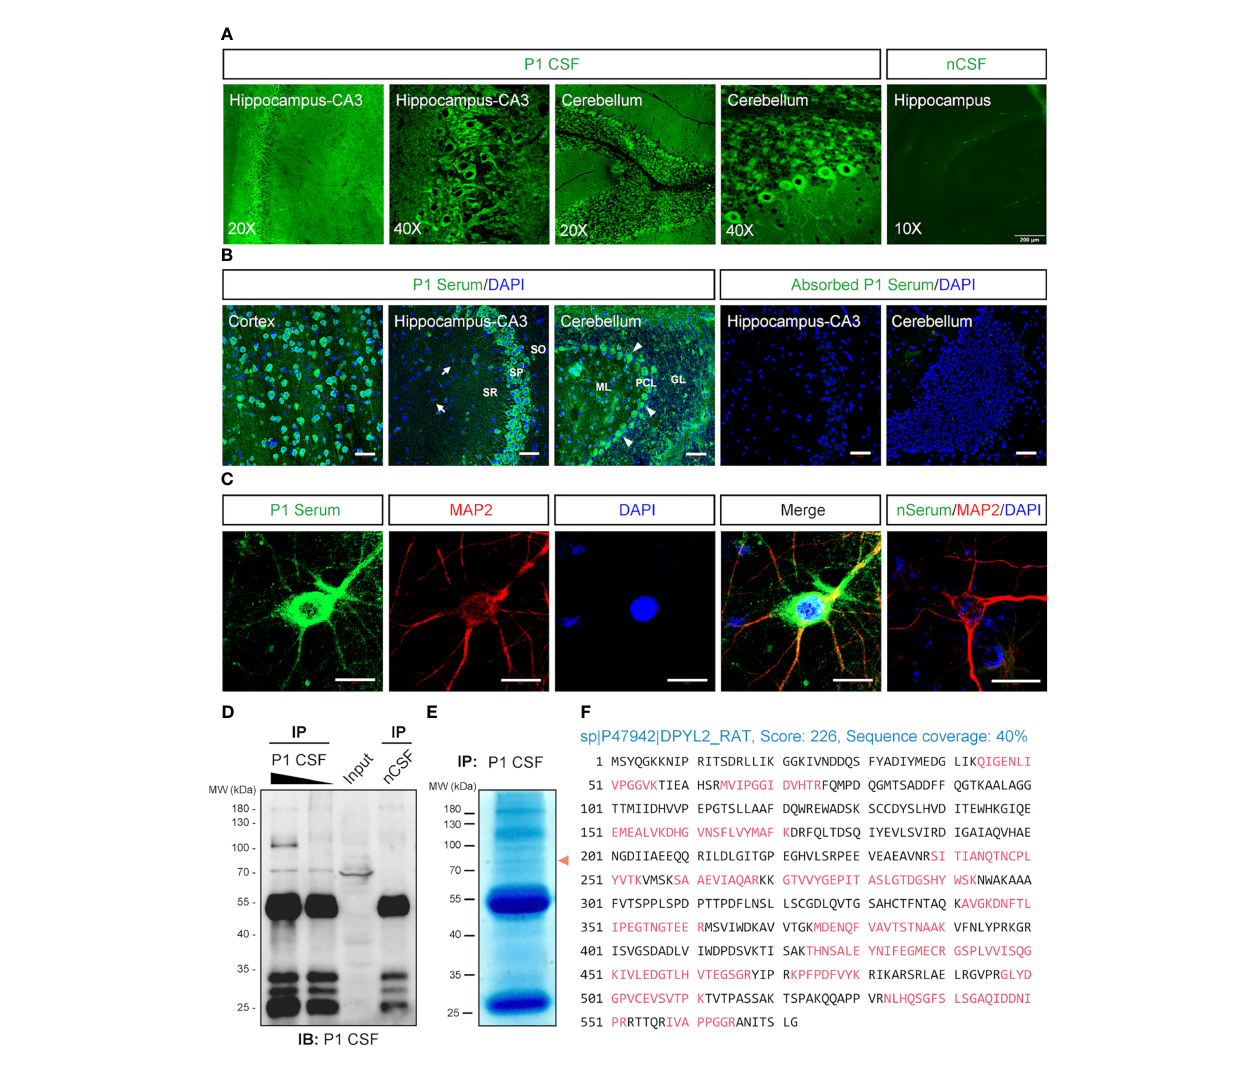
FIGURE 3 | Identi fi cation of the autoantibody in a patient with acute encephalitis. P1 patient was diagnosed with encephalitis. The CSF sample from a control patient with carpal tunnel syndrome (nCSF) and the serum from a healthy person (nSerum) was used as negative controls. (A) Immunostaining on rat brain sections. The CSF from P1 patient had stained on hippocampus and cerebellum. (B) P1 patient ’ s serum stained obviously in the cytosolic compartments of the neurons in the cortex, CA3 area of the hippocampus, and cerebellum on mouse brain sections (green). White arrows, possible oligodendrocytes; arrow heads, Purkinje cells. CRMP2-expressing HEK293T cell absorbed P1 patient ’ s serum had no obvious staining. Cell nuclei were stained blue with DAPI. (C) P1 patient ’ s serum (green) stained positively in the soma and dendrites of cultured mouse cortical neurons which were labeled with anti-MAP2 Ab (red). (D, E) IP of P1 CSF with rat brain protein lysate. In total, 500 m l (lane 1) and 100 m l (lane 2) P1 CSF were applied to IP with 10 mg total protein of fresh rat brain lysate, respectively. Moreover, 500 m l nCSF was used for negative control. A positive band around 70 kDa was pulled down by P1 CSF but not by nCSF. A similar protein size band (red arrowhead) was observed on a parallel gel with Coomassie brilliant blue staining (E) . (F) Characterization of the autoantigen by mass spectrometry. The suspected protein band in (E) was collected for protein identi fi cation by LC-MS/MS. Seventeen identi fi ed peptides (red) matched rat DPYL2 (UniProtKB ID: P47942), an alias of CRMP2, with a score of 226 and sequence coverage of 40%. CRMP2, collapsin response mediator protein 2; CSF, cerebrospinal fl uid; DAPI, 6-diamidino-2-phenylindole; DPYL2, dihydropyrimidinase like 2; GL, granular layer; IB, immunoblotting; IHC, immunohistochemistry; IP, immunoprecipitation; LC-MS/MS, liquid chromatography tandem mass spectrometry; MAP2, microtubule-associated protein 2; ML, molecular layer; PCL, Purkinje cell layer; SO, stratum oriens; SP, stratum pyramidale; SR, stratum radiatum. Scale bars represent 50 m m in (B) and 20 m m in (C)